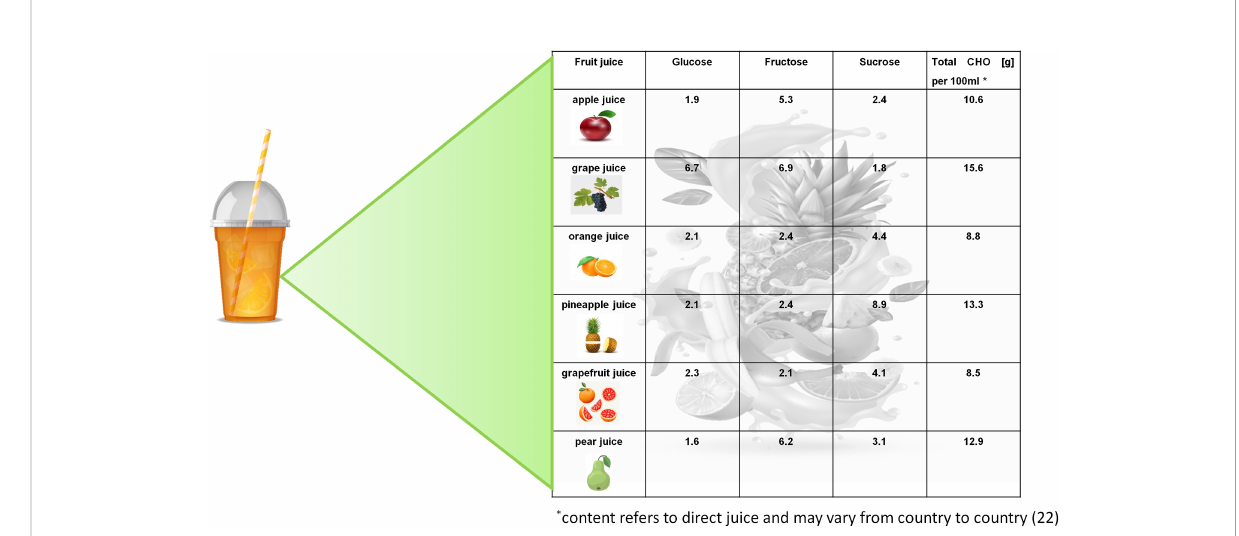
FIGURE 1 Glucose, fructose and sucrose contents [g/100 ml] in different fruit juices. Graphics: